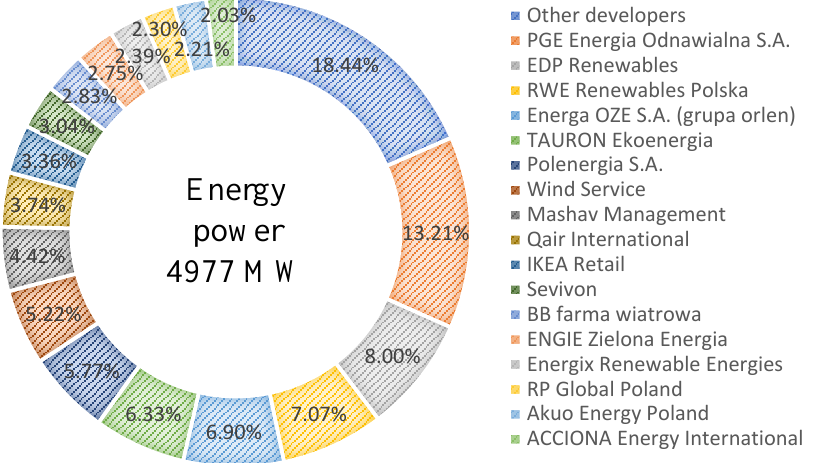
Figure 4. Shares of RES market participants (%) with 4977 MW of the capacity for wind energy.